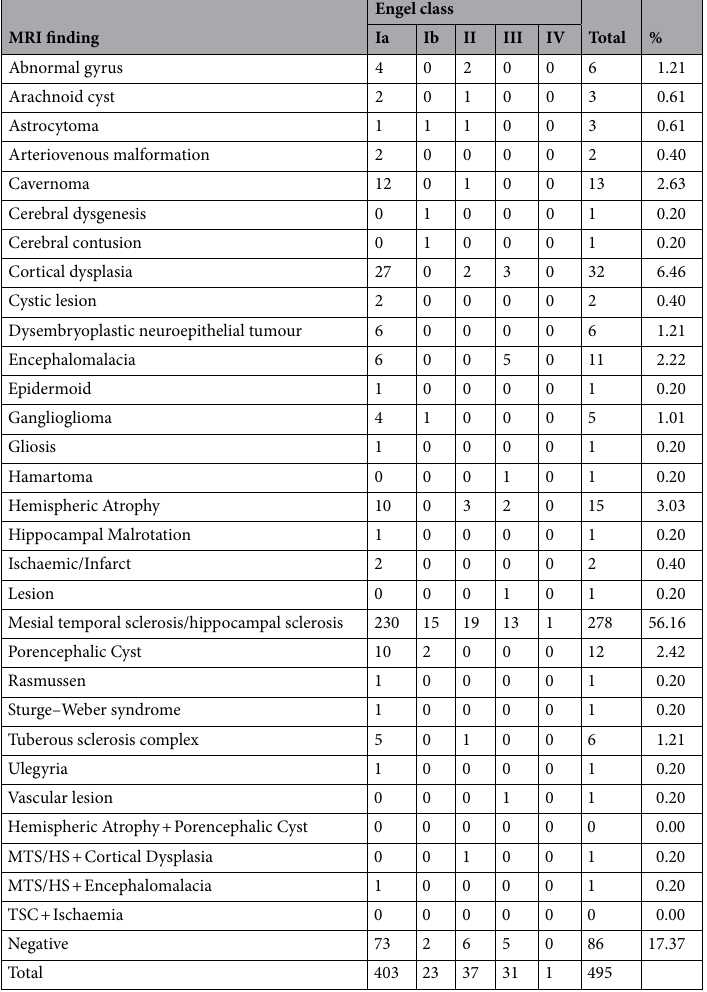
Table 4. Surgical outcome based on pathology. MRI Magnetic resonance imaging, AVM Arteriovenous malformation, DNT Dysembryoplastic neuroepithelial tumour, MTS/HS Mesial temporal